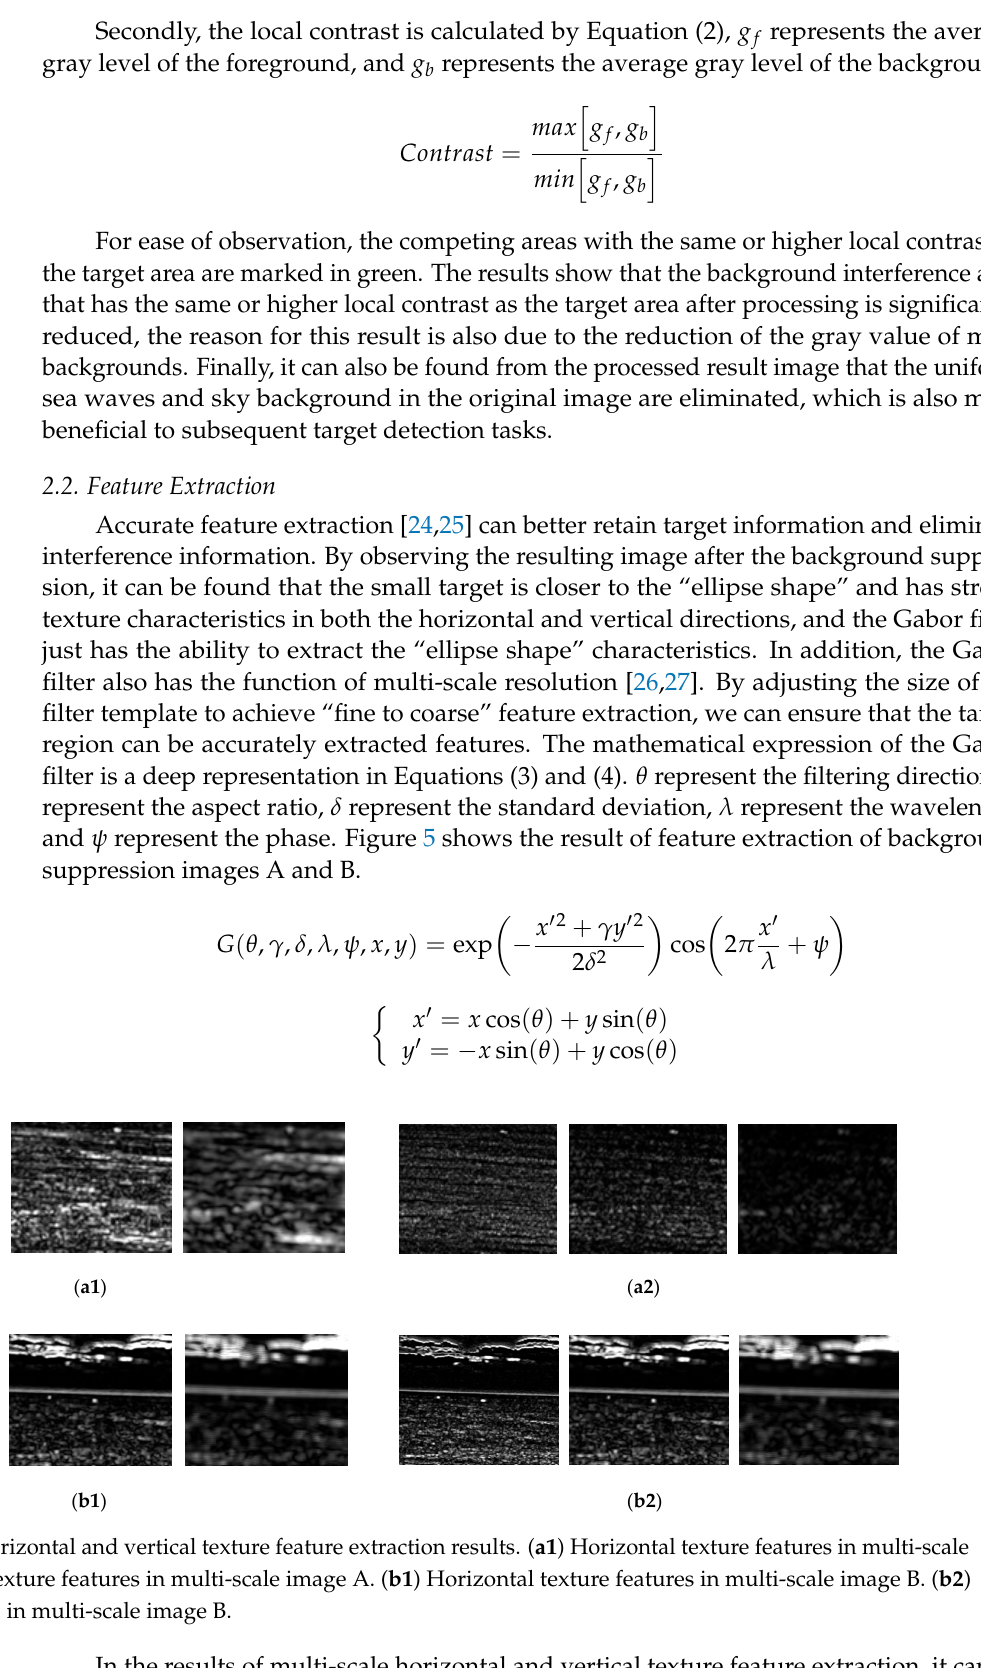
Figure 4. Global gray histogram and local contrast of typical original image and background sup- pression result.